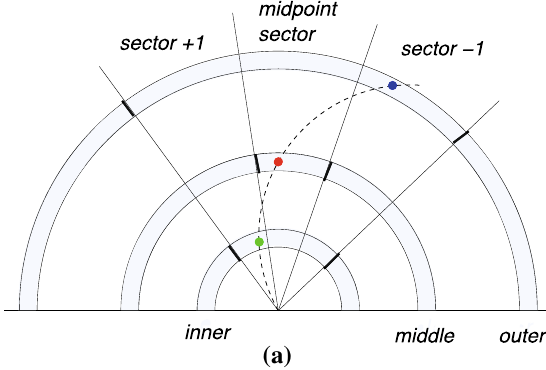
b track seed formation in the r – z plane, where the extrapolated z posi- tion of the triplet at the beamline can be restricted to within a specific z